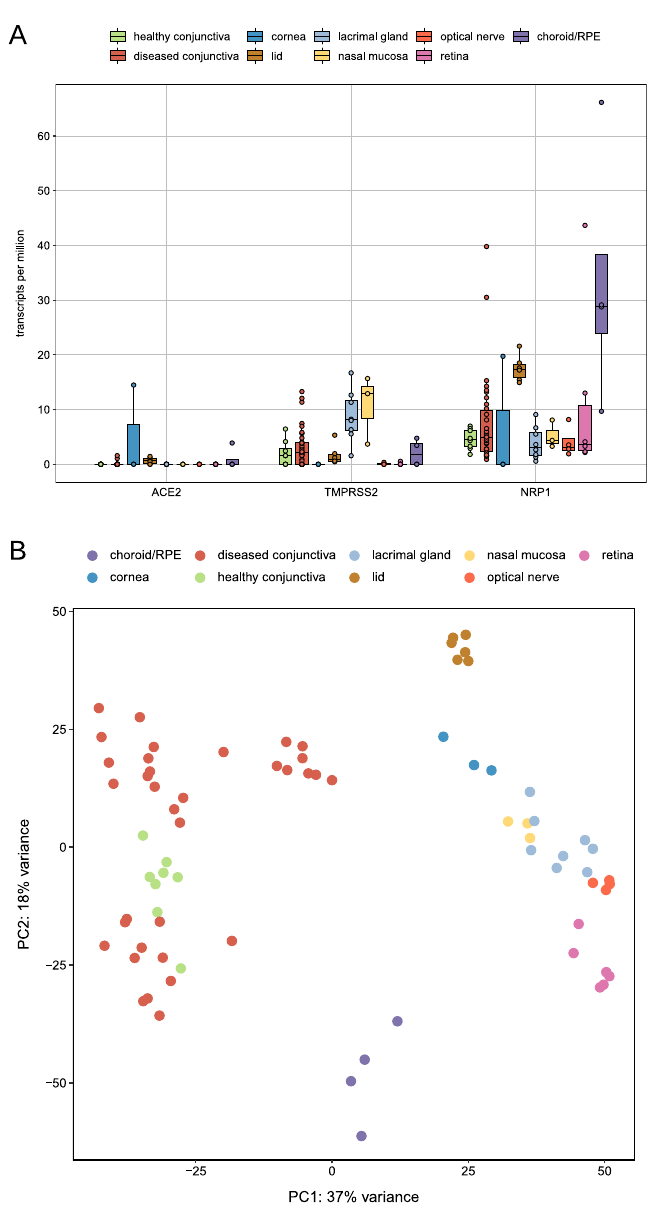
Figure 3. RNA sequencing. Boxplots showing ACE2, TMPRSS2 and NRP1 expression levels of all analyzed ocular samples (n = 63). Each dot represents one sample. Number of specimens: healthy conjunctiva: 8, diseased conjunctiva: 34, lacrimal gland: 8, nasal mucosa: 3, retina: 6, RPE/choroid: 4. ACE2 : Angiotensin I Converting Enzyme 2, TMPRSS2 : Transmembrane Serine Protease 2, NRP1 : Neuropilin